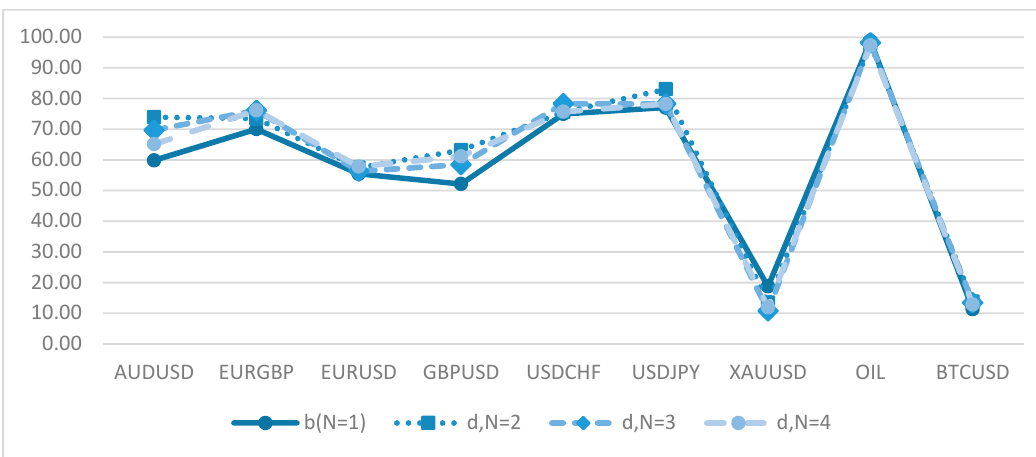
Figure 11. Drawdown, as percentage of equity, of experiment (e) for various values of N. Again, it is evident that the simple MACD Expert Advisor generally produces better results than the MACD, which opens positions with the hierarchy of lines. 3.3. Constant ATR Zone, Sliding ATR Zone, Sliding and Variable ATR Zone The first Stop Loss strategy we examined was f) a MACD Expert Advisor that creates a Stop Loss zone at ± x × ATR(N) when it opens a new position and a new position prevention zone at ± y × ATR(N), after a position has to be closed due to a Stop Loss that has been triggered. We tested every combination of parameters for N:{12,24,36,48}, x :{1,2,3,4,5,6,7}, and y :{1,2,3,4}. The Net Profits for each asset for every combination of N, x , y have been outlined in Figure 12 and Drawdown in Figure 13.